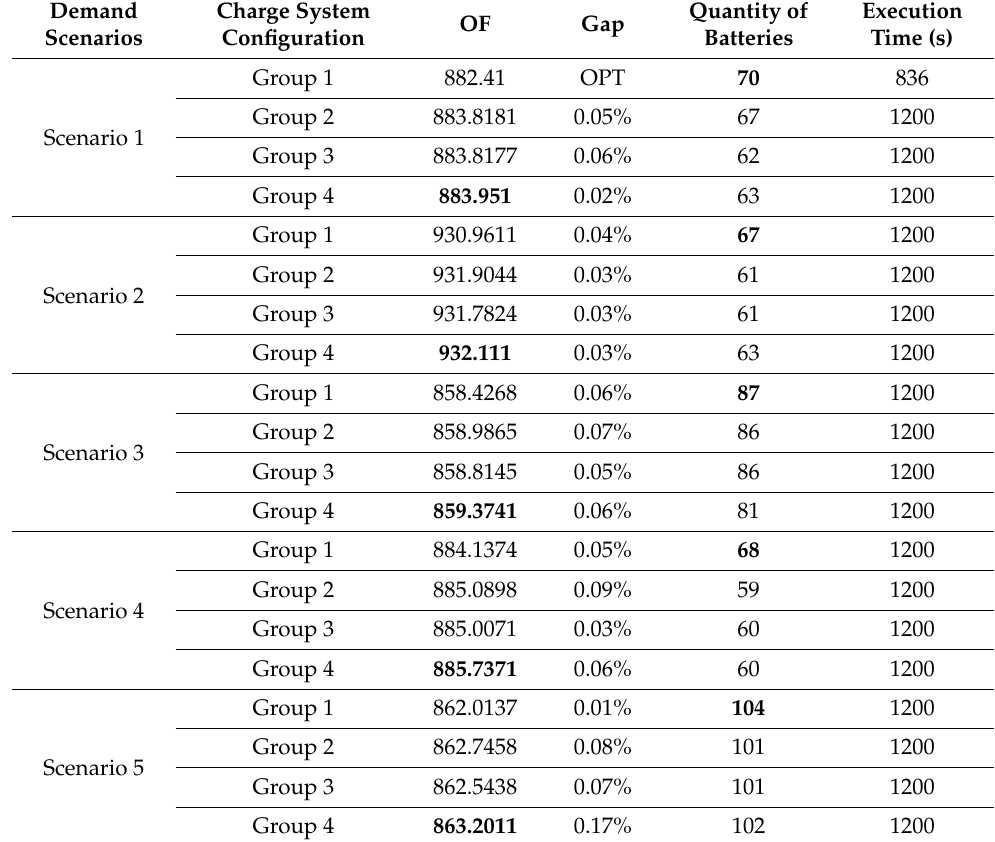
Table 11. Model results: objective function, OF gap, number of batteries, and